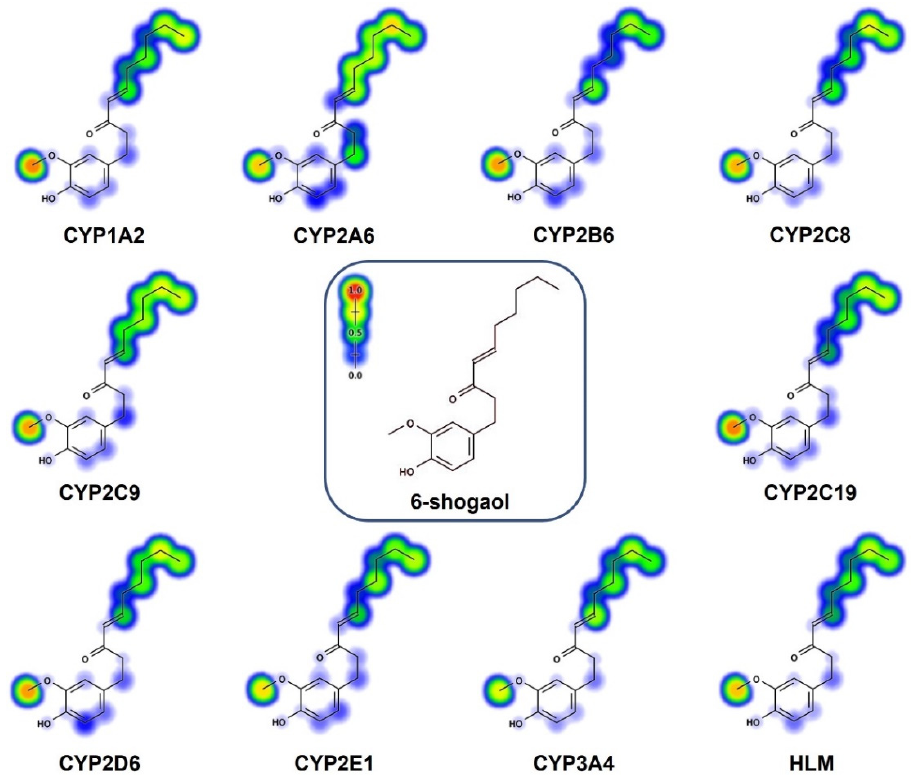
Figure 7. In silico evaluation of the metabolism of 6-shogaol. Metabolic sites (SOM) of 6-shogaol mediated by CYP450 isoenzymes (CYP1A2, CYP2A6, CYP2B6, CYP2C8, CYP2C9, CYP2C19, CYP2D6, CYP2E1, CYP3A4, and HLM).